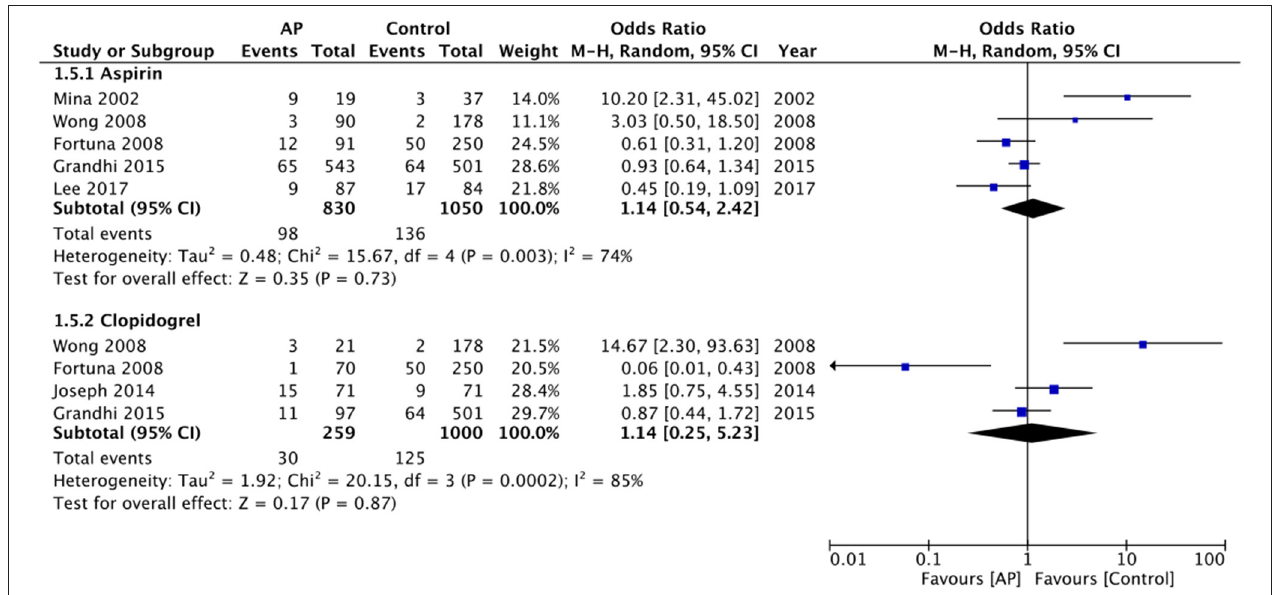
FIGURE 4 | Meta-analysis of crude early mortality rates between antiplatelet users vs. controls based on the type of